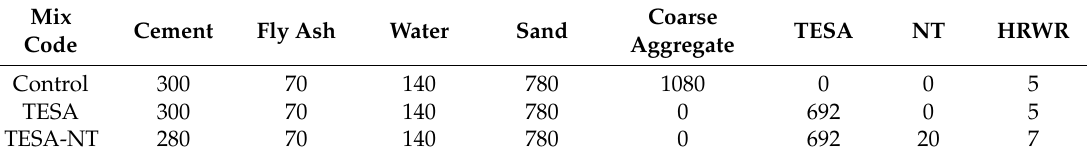
Table 3. Mix proportion of samples (kg/m 3 ).